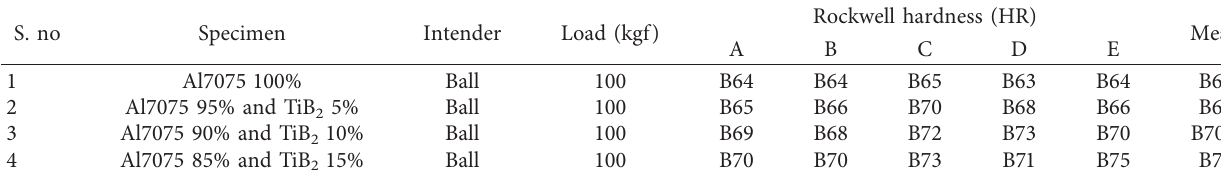
Table 3: Hardness value for prepared samples.